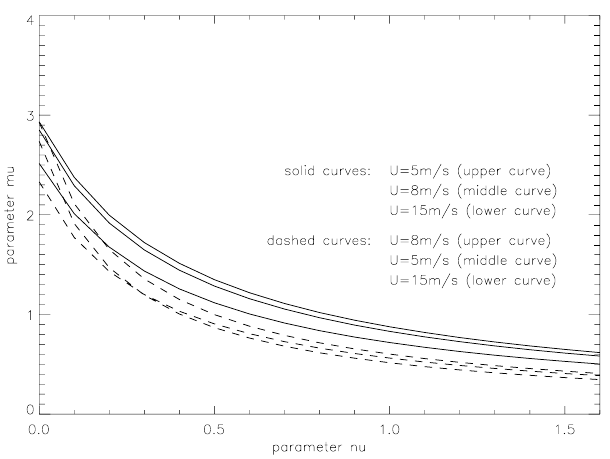
Fig. 5. Spectral flux parameter µ as a function of diffusion param- eter ν , displayed for 5, 8, and 15ms − 1 wind speeds. The sea wave spectral models are the same as in Fig. 1, involving high wavenum- ber spectrum from Elfouhaily et al. (1997) (solid lines) or from Kudryavtsev et al. (2003) (dashed Figure 5. Spectral flux parameter µ as a function of diffusion parameter ν , displayed for 5, 8, and 15 m/s wind speeds. The sea wave spectral models are the same as in Figure 1, involving high wavenumber spectrum from Elfouhaily et al. (1997) (solid lines), or from Kudryavtsev et al. (2003) (dashed lines).